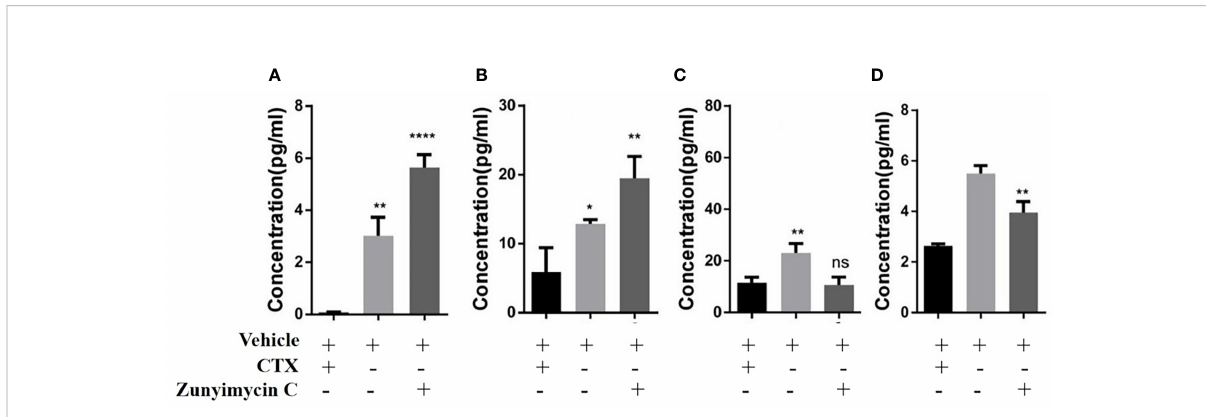
FIGURE 9 Effect of drugs on cytokine in mice. (A) the level of IL-2. (B) the level of IL-6. (C) the level of IFN- g . (D) the level of TNF- a l. *P < 0.05; **P < 0.01; ****P < 0.0001; ns, No statistical difference.